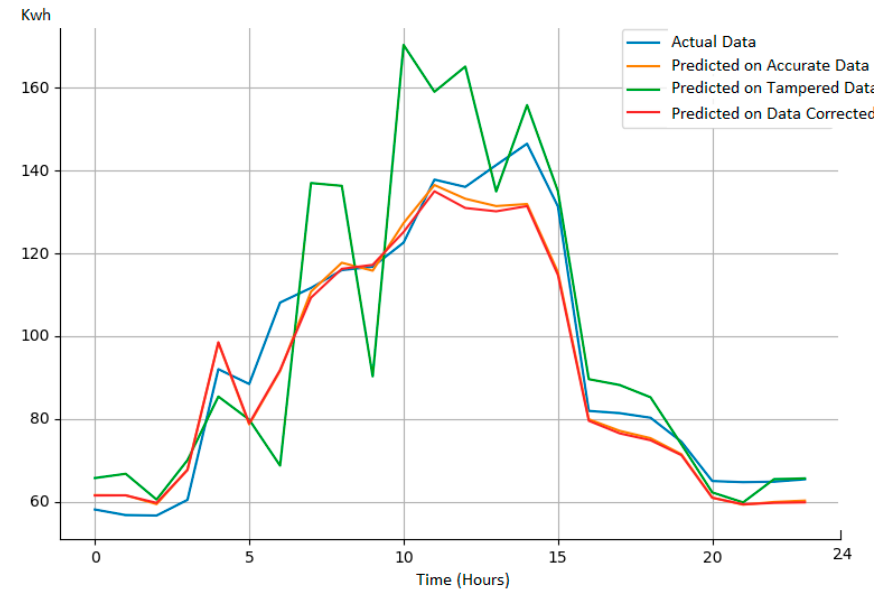
Figure 14. Forecasting process result details on various input data.